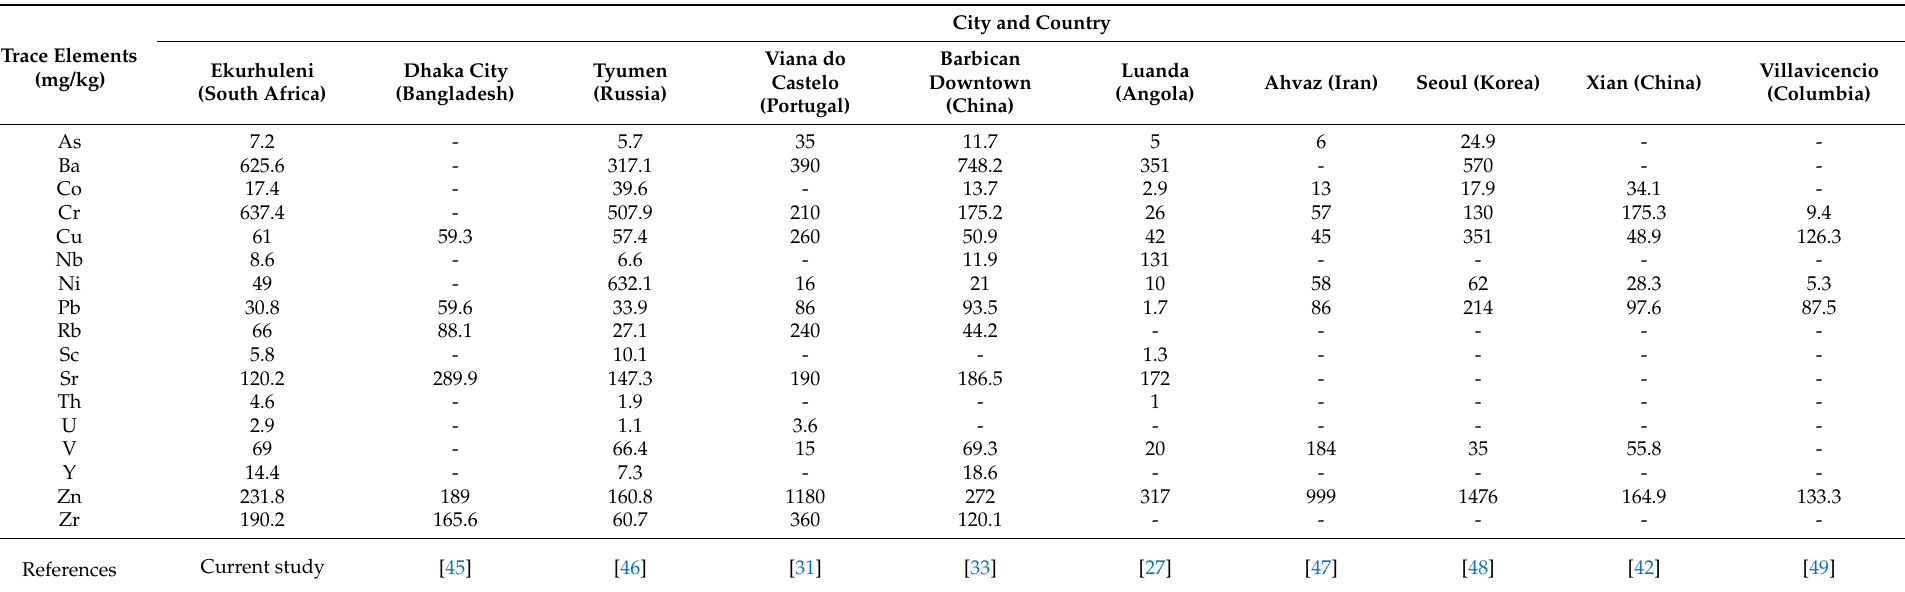
Table 5. Comparison of trace elements (mg/kg) in road dust with other global